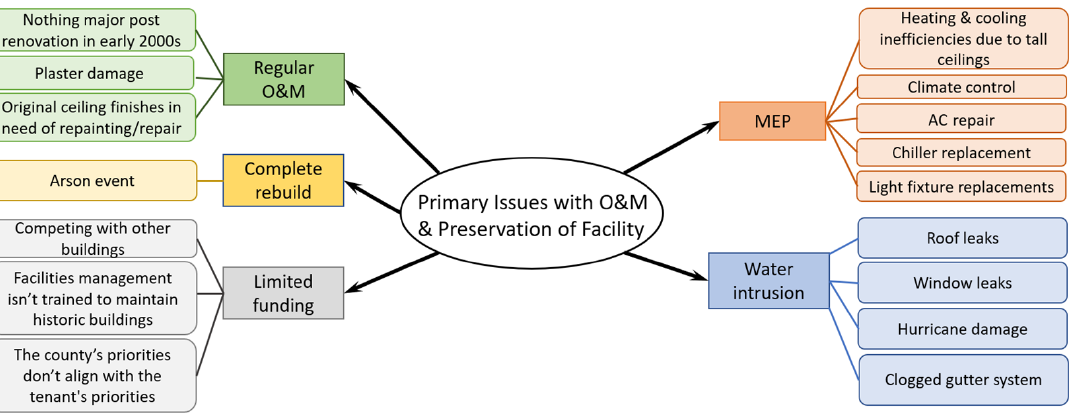
Figure 11. Results to interview question #1: primary issues with O&M and preservation of the his ‐ toric courthouses. historic